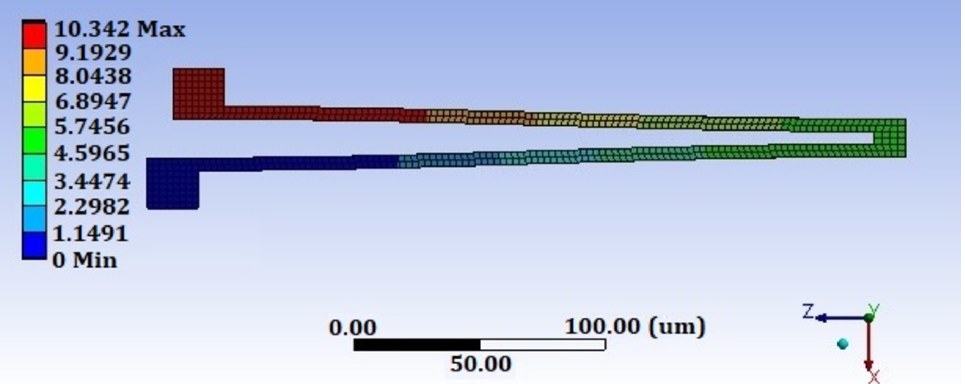
Figure 15. The results of checking the analytical calculations of the elastic beam using